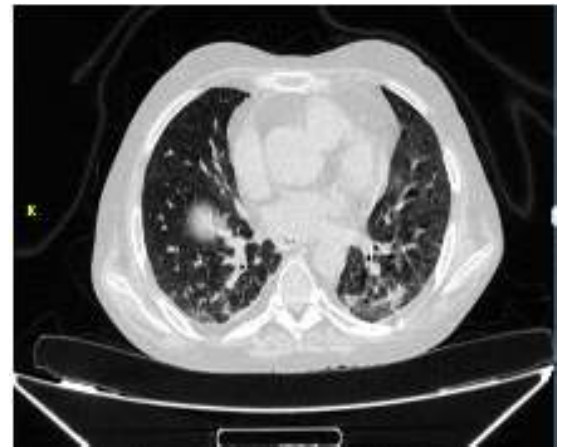
Figure 1. Opacities and nodules in Right upper lobe